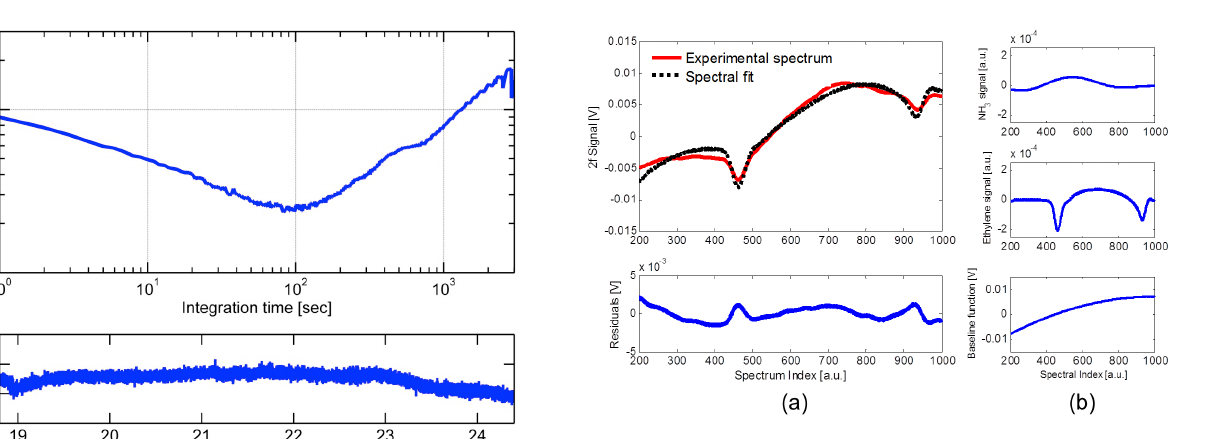
Fig. 7. (a) Second harmonic spectrum of 1.0ppbv NH 3 signal at Figure 7. (a) Second harmonic spectrum of 1.0 ppbv NH 3 signal at ambient pressure recorded 2 ambient pressure recorded at 1Hz along with spectral fitting results at 1 Hz along with spectral fitting results and residuals. (b) Base functions used in spectral 3 and residuals. (b) Base functions used in spectral fitting in (a) as fitting in (a) as follows: 2f NH 3 lineshape (top), 2f ethylene lineshape (middle) and 4 follows: 2f NH 3 lineshape (top), 2f ethylene lineshape (middle) and polynomial baseline (bottom). 5 polynomial baseline